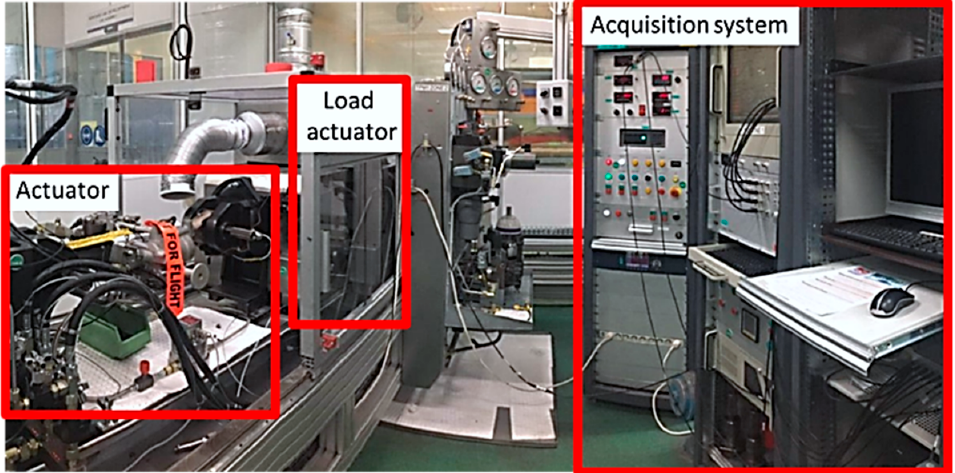
Figure 4. The experimental set-up.